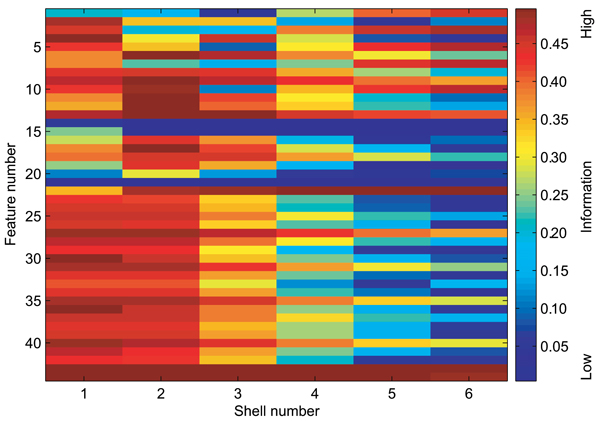
Distribution of fi over all the FEATURE vectors used. The weight used in the F-distance, fi, is related to the information content of feature i, and weights the distance computed between two FEATURE vectors. The values of fi are calculated from the distribution of ones and zeros in feature i over the entire two million FEATURE vectors used. This heat map shows the values of fi over all 44 features in each of the 6 shells.